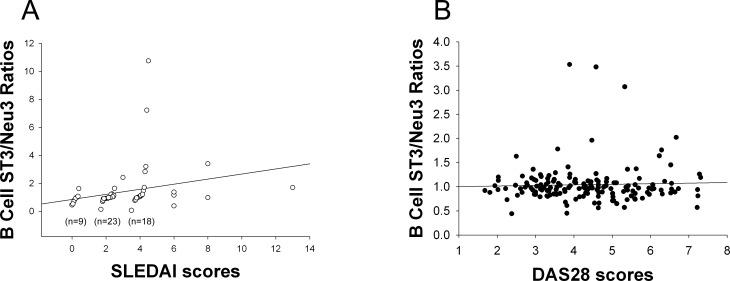
Correlation between the B-cell ST3Gal-1/Neu3 ratios and SLEDAI or and DAS28.B cells were stained as described in Patients and methods. The B-cell ST3Gal-1/Neu3 ratio indicated the ratio of the mean fluorescence intensity (MFI) of the B-cell’s ST3Gal-1 staining results divided by the MFI of the same B-cell’s Neu3 staining results. (A) Positive correlation between the B-cell ST3Gal-1/Neu3 ratio and SLEDAI. SLEDAI: systemic lupus erythematosus disease activity index; In order to have distinctive circles in the graph, those circles with SLEDAI scores equal to 0, 2, and 4 were adjusted on one-to-two figure(s) to the right of the decimal point either above or below 0, 2, and 4. The correlation was ρ = 0.409 and P = 0.002 (n = 57). It was statistically significant when compared with a significant P-value = 0.0125 after Bonferroni’s correction was done with no significant correlation was found for correlating the ST3Gal-1/Neu3 ratio of T and PMN cells, and monocytes with SLEDAI scores. (B) Correlation between B-cell ST3/Neu3 ratios and DAS28 (disease activity score28) at r = 0.039 and P = 0.631 (n = 157).